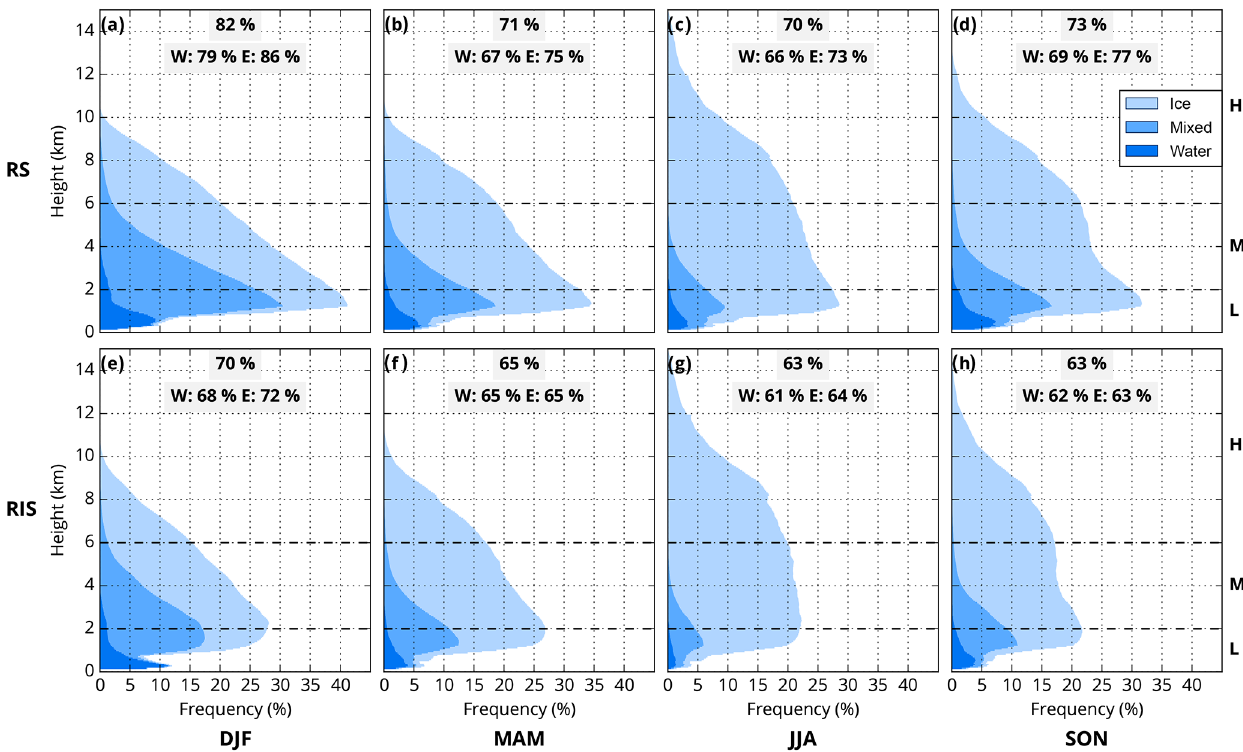
Figure 4. Mean vertical profiles of cumulative cloud occurrence for different cloud phases derived from 2BCL4 data for the Ross Sea (a– d) and RIS sectors (e–h) for different seasons. Total sector cloud fraction (temporal average cloud occurrence independent of altitude) is annotated at the top of each sub-figure, along with values for the western (W) and eastern (E) halves of each sector. L, M, and H labels indicate the low, medium, and high cloud regions, respectively, as discussed in the